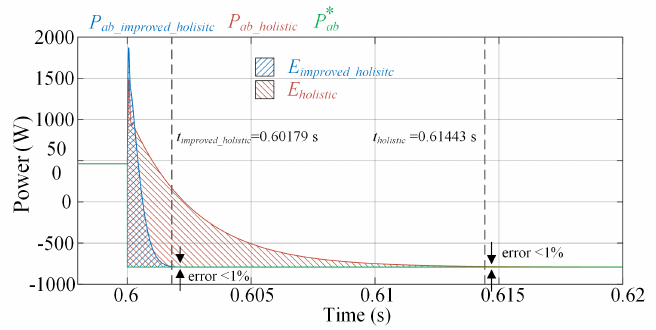
Figure 12. Change from GCI to GCR from 462.8 W to − 791.8